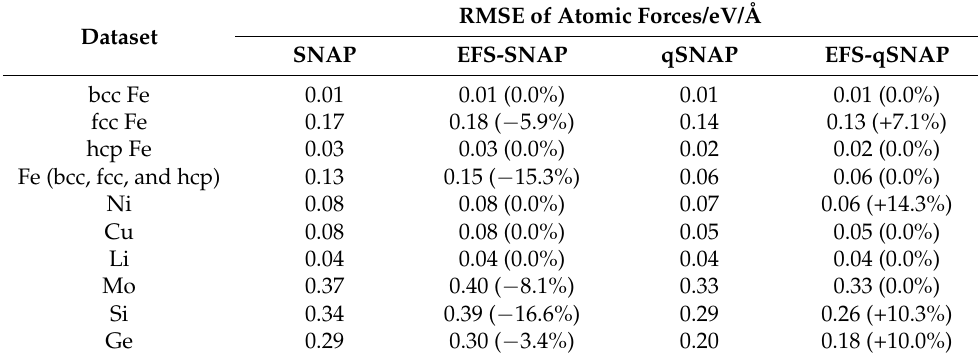
Table 3. RMSE comparison of force between qSNAP and